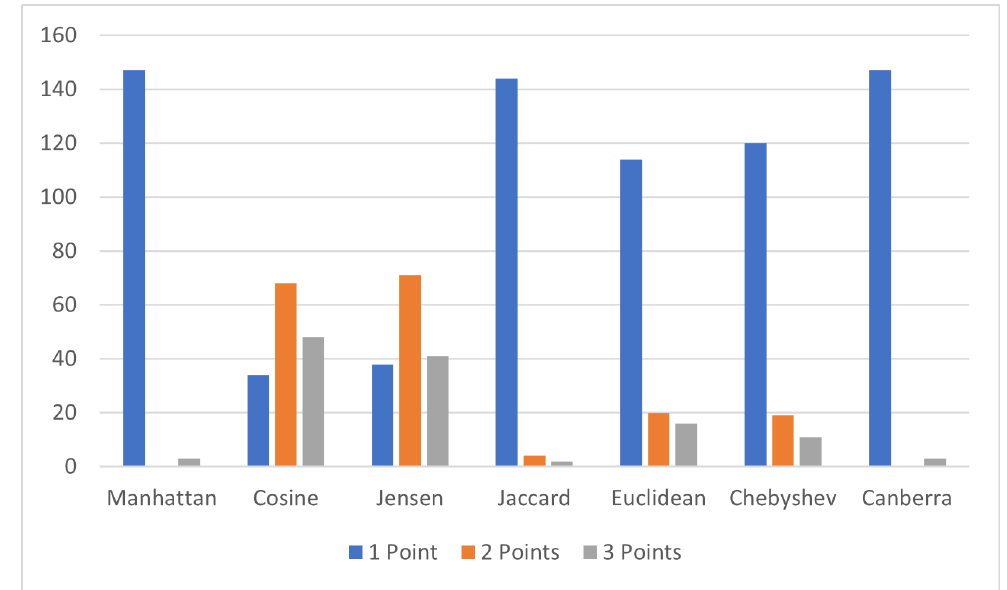
Figure 9. Human judgment results using LDA and respective similarity